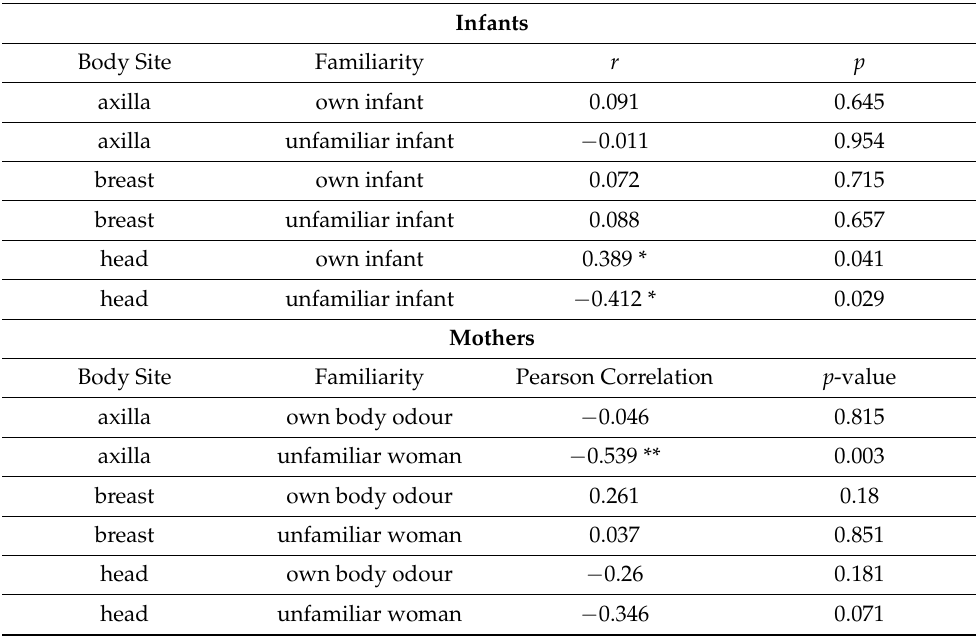
Table A5. Pearson’s correlation coefficients for exploratory analyses of the relation between pleasant- ness and intensity perception. The correlations were computed for the familiar and the unfamiliar odour each. * p < 0.05; ** p < 0.01. Pearson Correlation for Intensity and Pleasantness Perceptions.